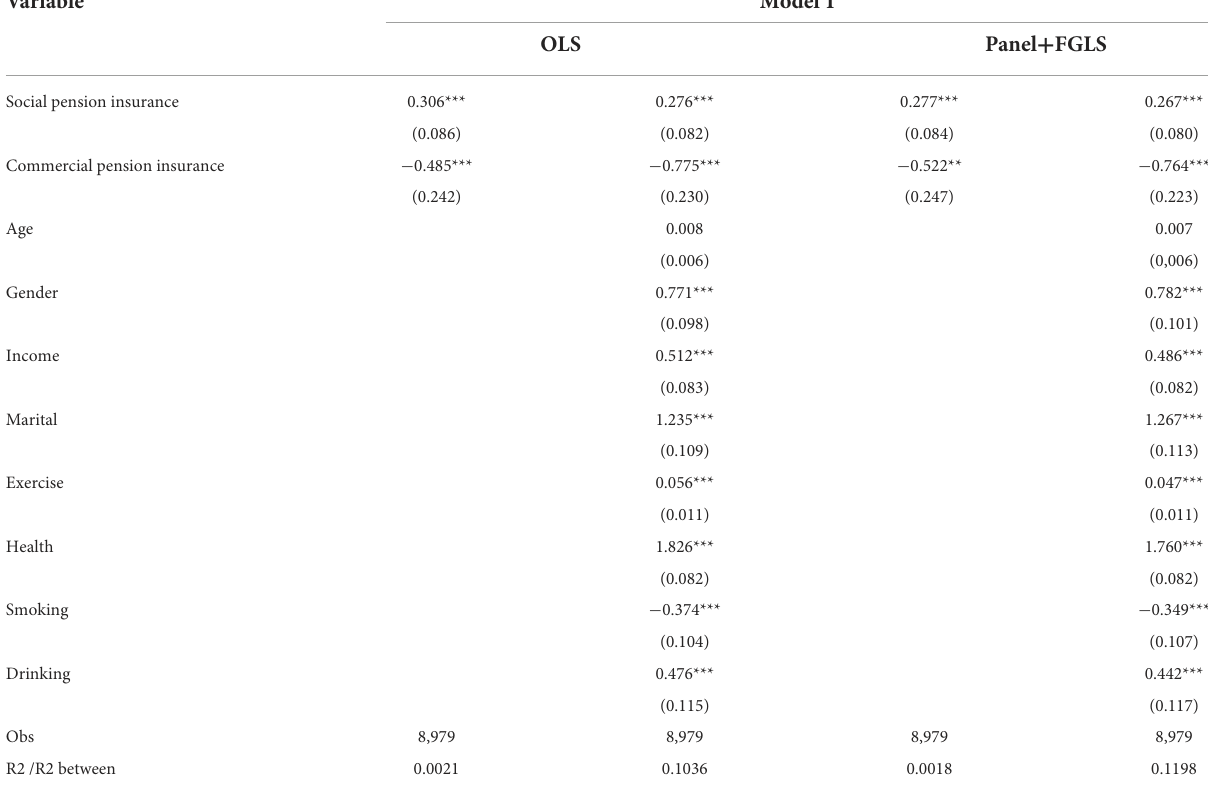
TABLE 3 Regression results of pension insurance on mental health of older adults.